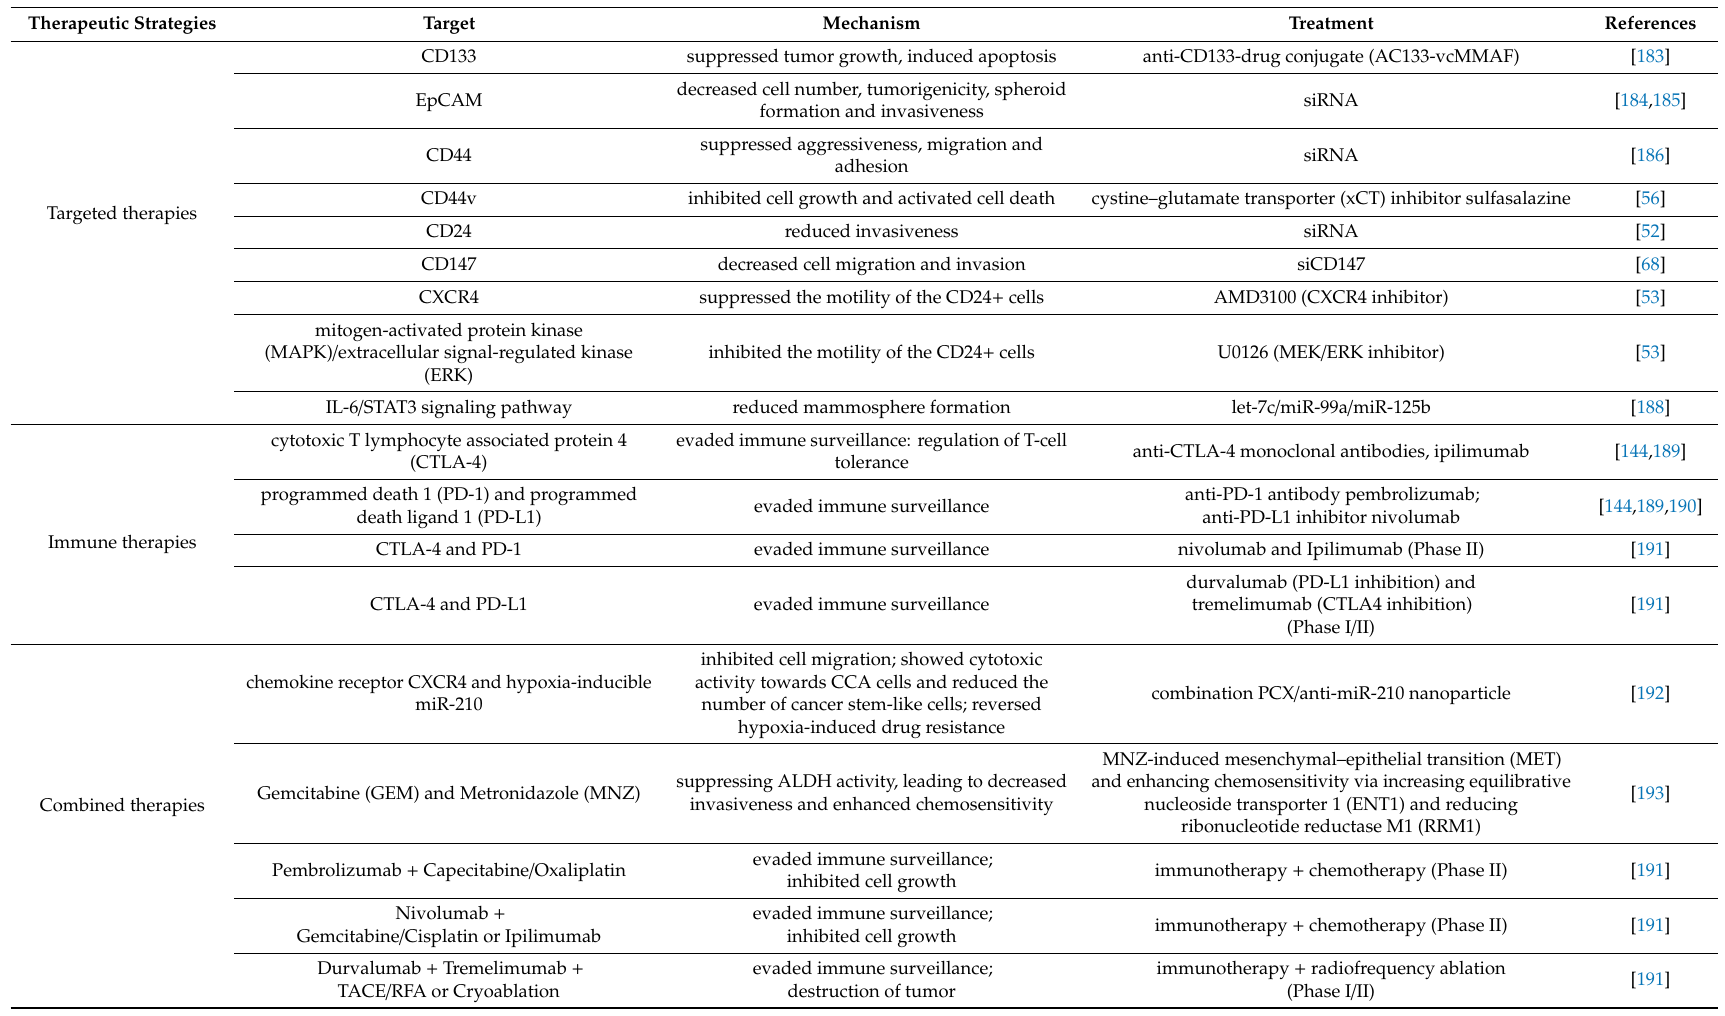
Table 2. The Potential Therapeutic Strategies for